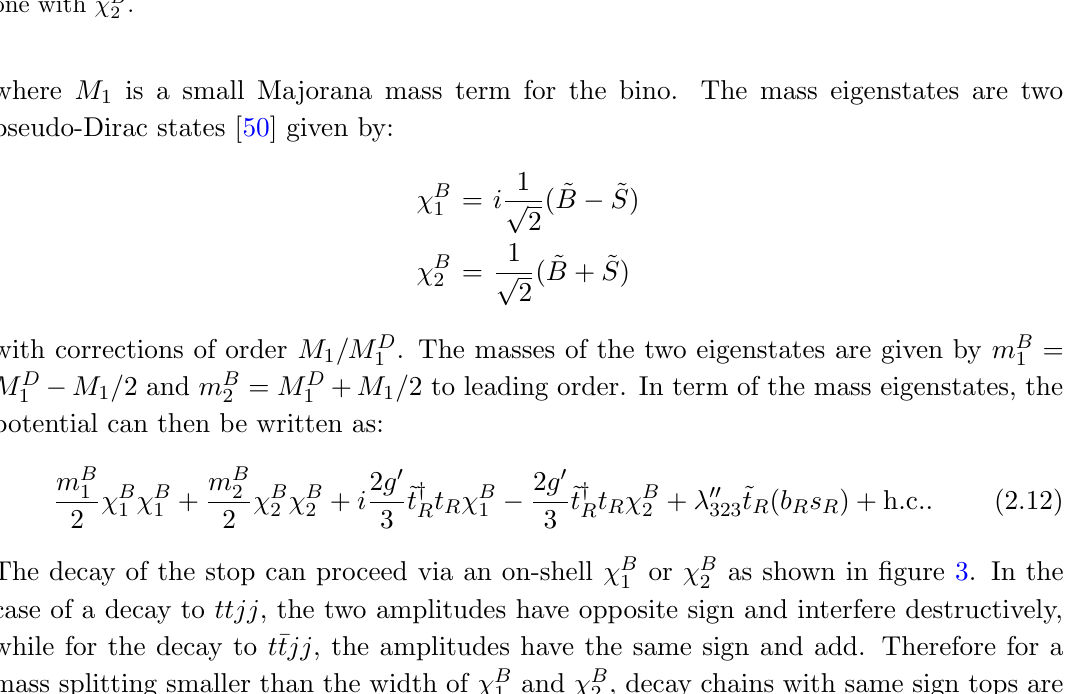
and (cid:31) B . When the 1 2 cancels the 1